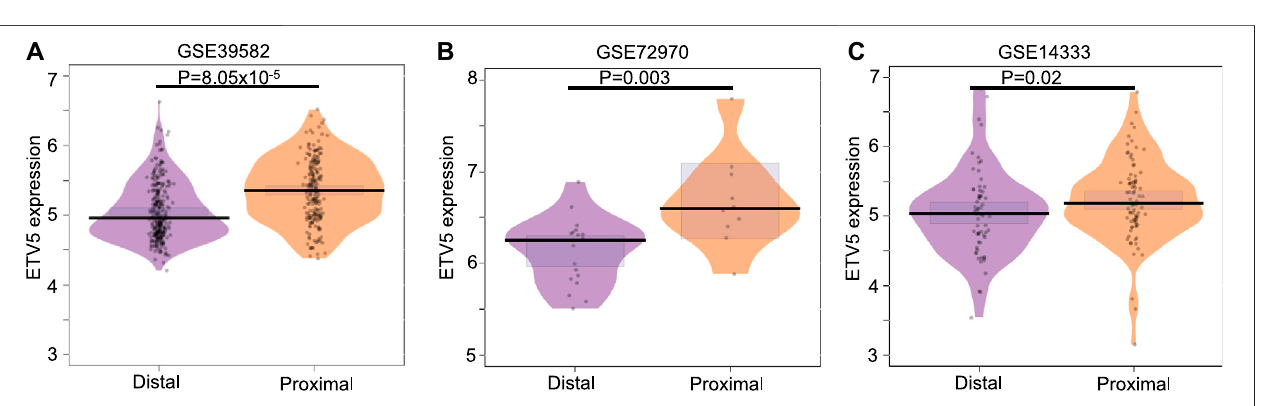
Frontiers in Pharmacology |